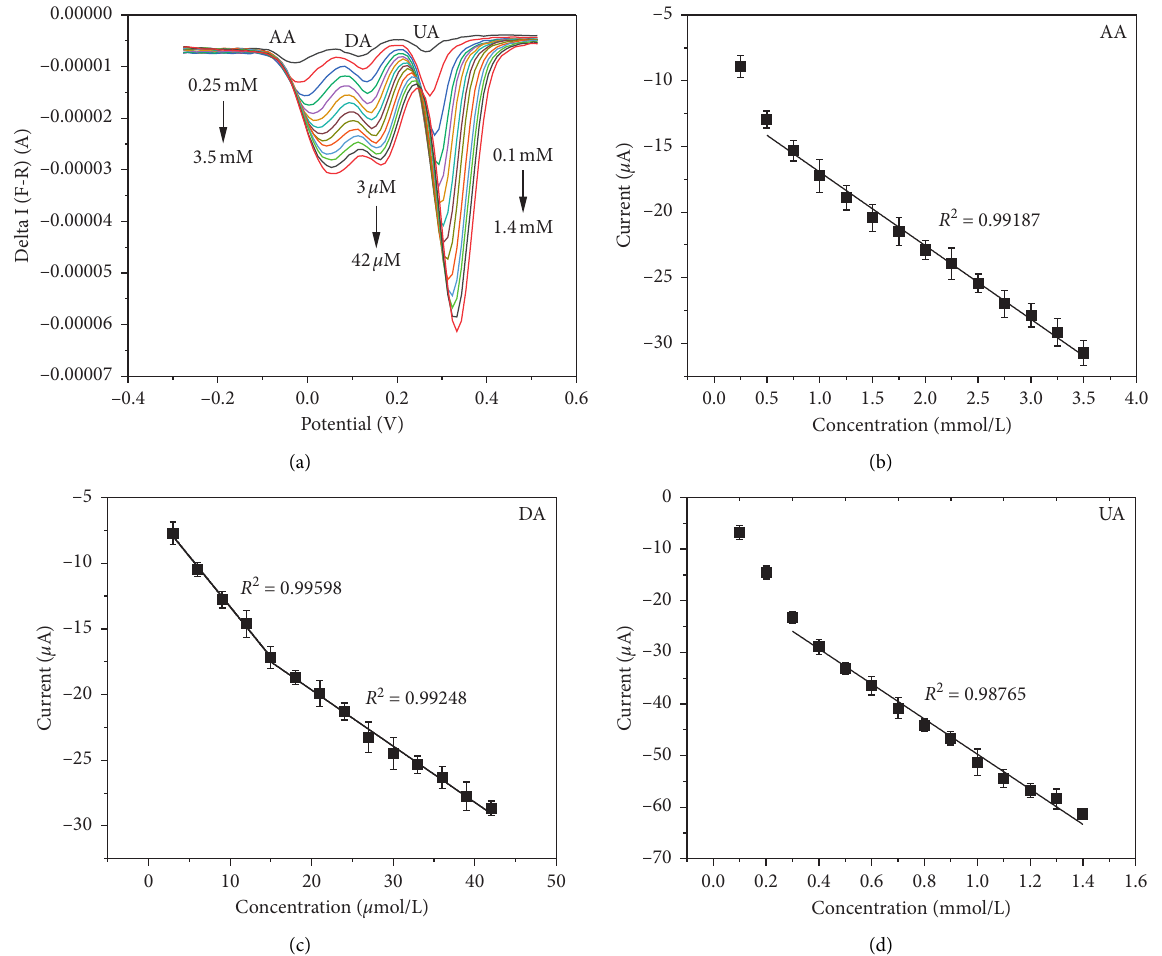
Figure 6: DPV curves of different concentrations of AA, DA, and UA (a); calibration plots for (b) AA, (c) DA, and (d) UA.